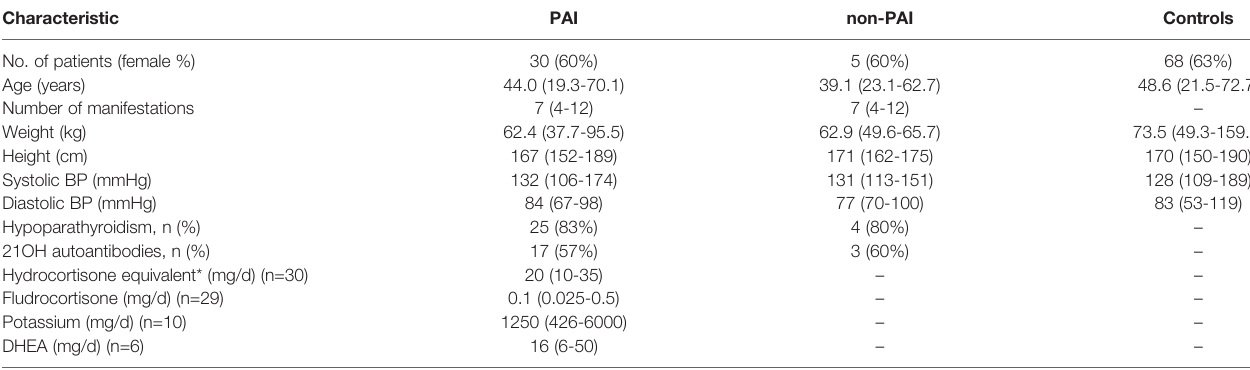
TABLE 2 | Table showing characteristics and measurements taken at the study visits of adult patients with primary adrenal insuf fi ciency (PAI) due to APECED, patients with APECED without PAI (non-PAI), and control subjects. Characteristic PAI non-PAI Controls